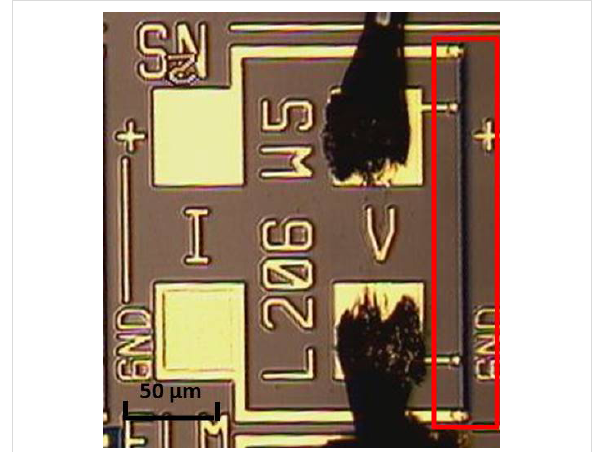
Figure 1: Optical micrograph of one of the CVD graphene-based chemiresistive devices. The graphene strip is highlighted in red. The length l and width w of the sensing strip (in µm) have also been indicat- ed and patterned between the